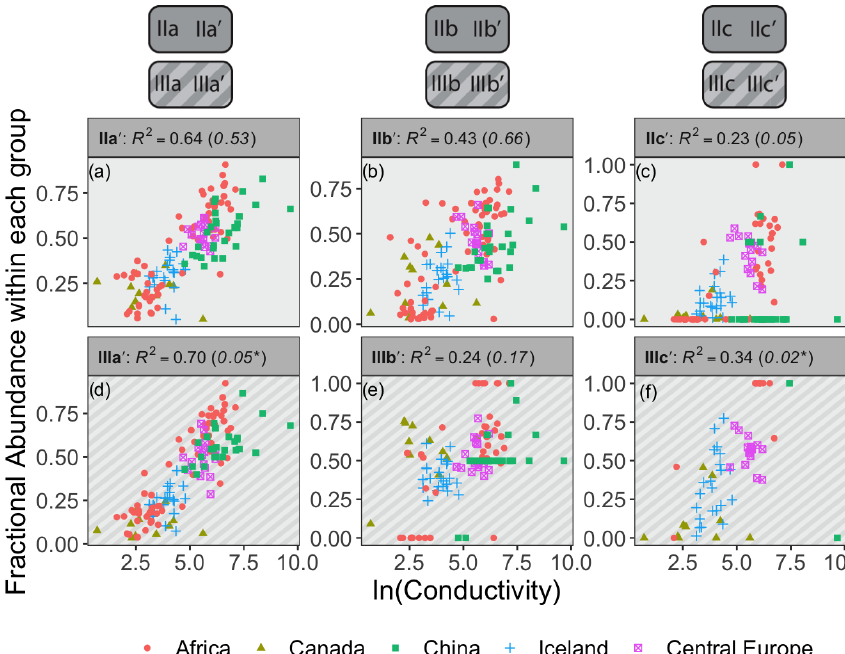
Figure 8. Relationships between the natural logarithm of conductivity and brGDGT FAs calculated within the Isom set. R 2 values are provided for each subplot, with R 2 values for the standard Full FAs given in parentheses for comparison. P values were < 0.01 except where marked with an asterisk. Note that plots of 5-methyl compounds are redundant because they exactly mirror those of their 6-methyl counterparts; only the 6-methyl FAs are